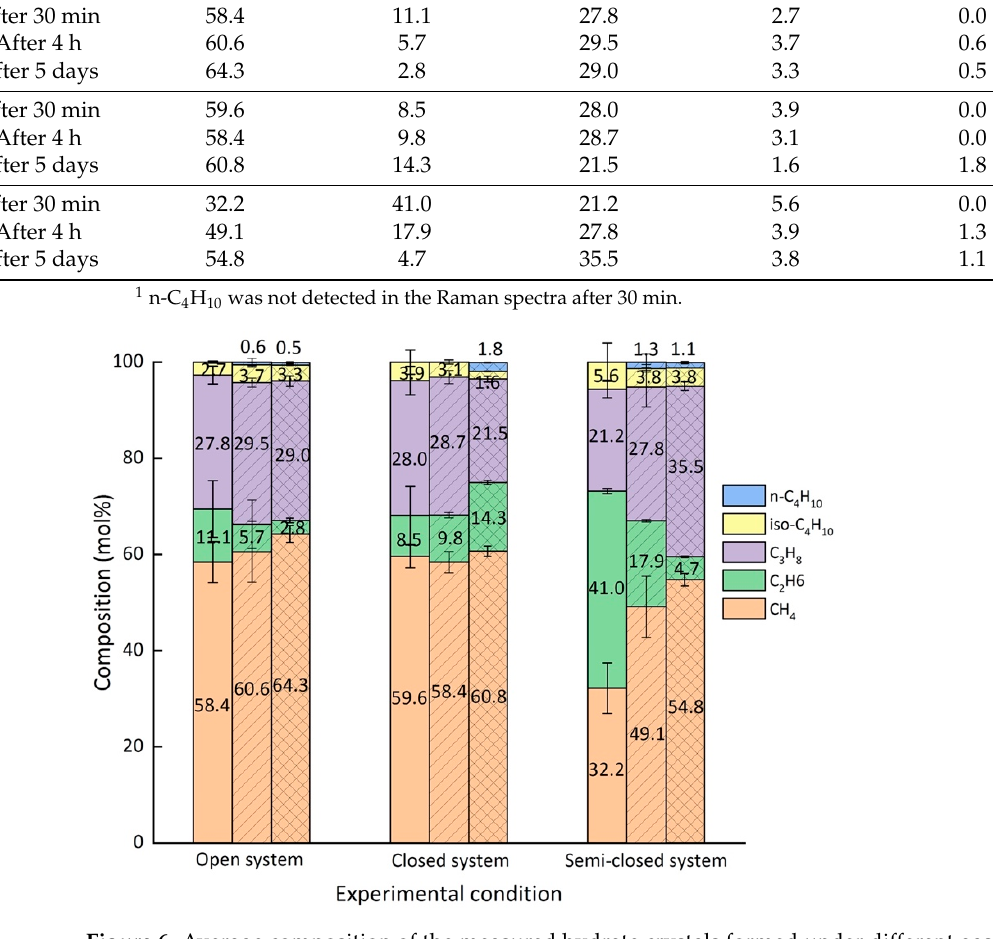
Figure 6. Average composition of the measured hydrate crystals formed under different gas supply conditions after 30 min (blank), after 4 h (shaded slash), and after 5 days (oblique line grid). The standard deviations of the average composition in repeated experiments were used for the descriptive error bars.